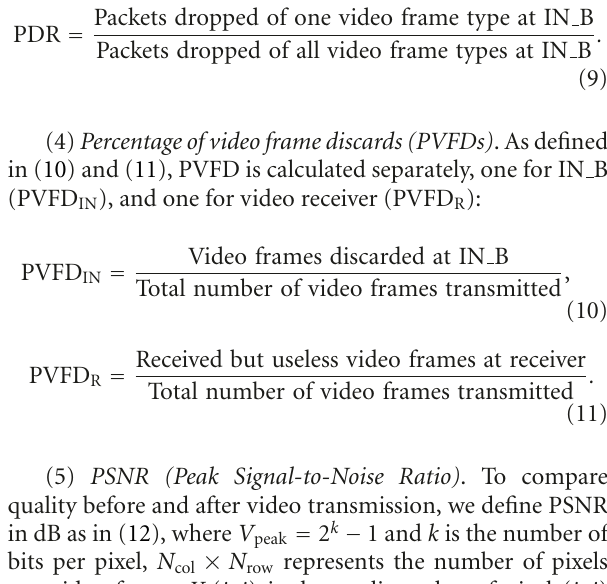
Figure 4: An Example of GOP in MPEG Compression ( M = 14, N =